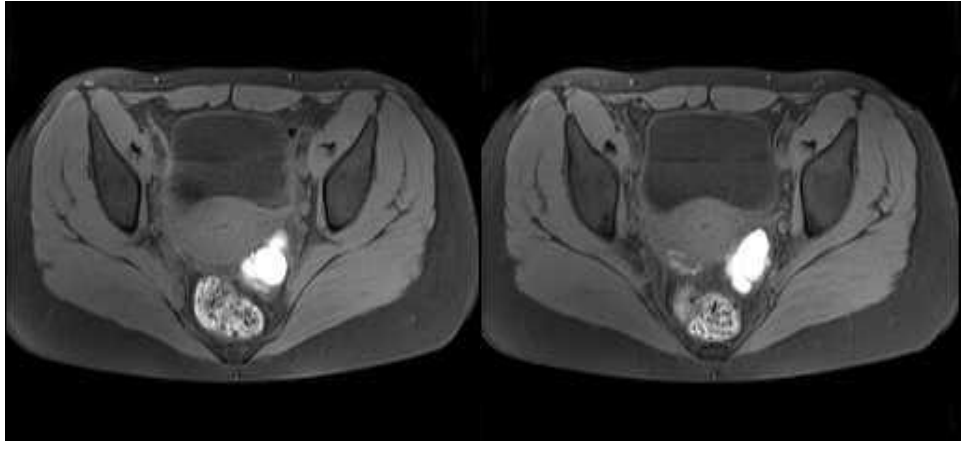
Figure 4. T1 VIBE weighed sequences. Marked hyperintense signal observed in the left ovary and a weakly hyperintense thin area is observed in the posterior uterine wall, referred to as an endometril implant.